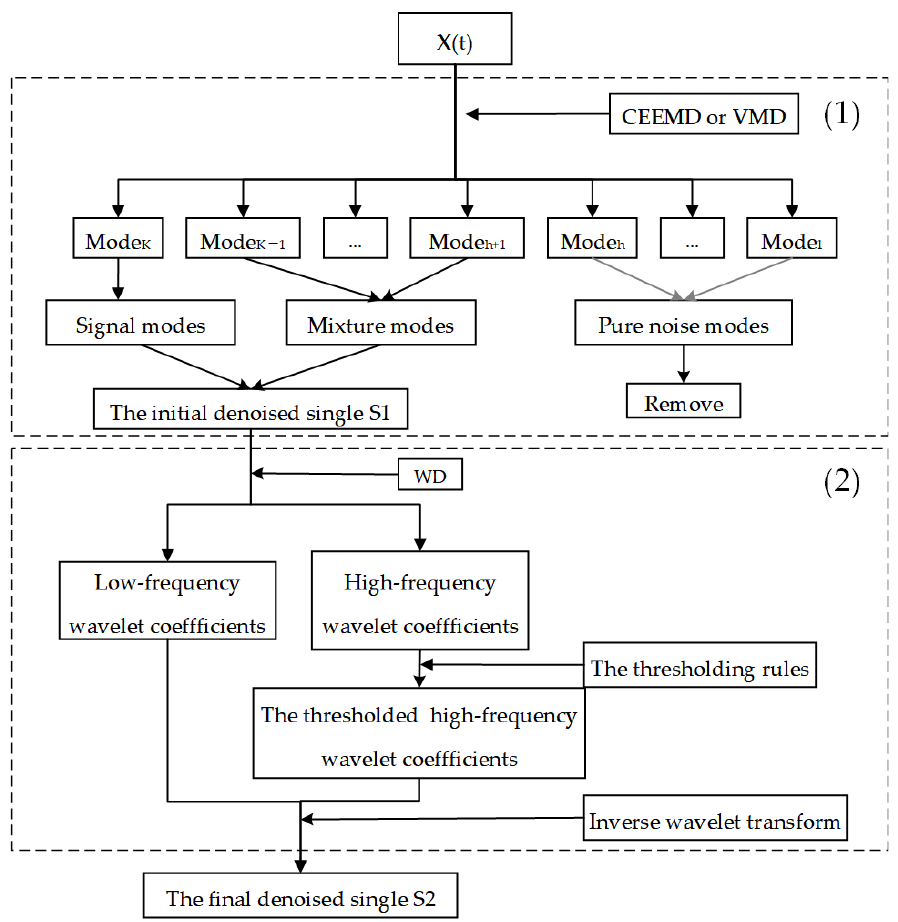
Figure 2. Flowchart of the two proposed methods for denoising GPS coordinate time series.